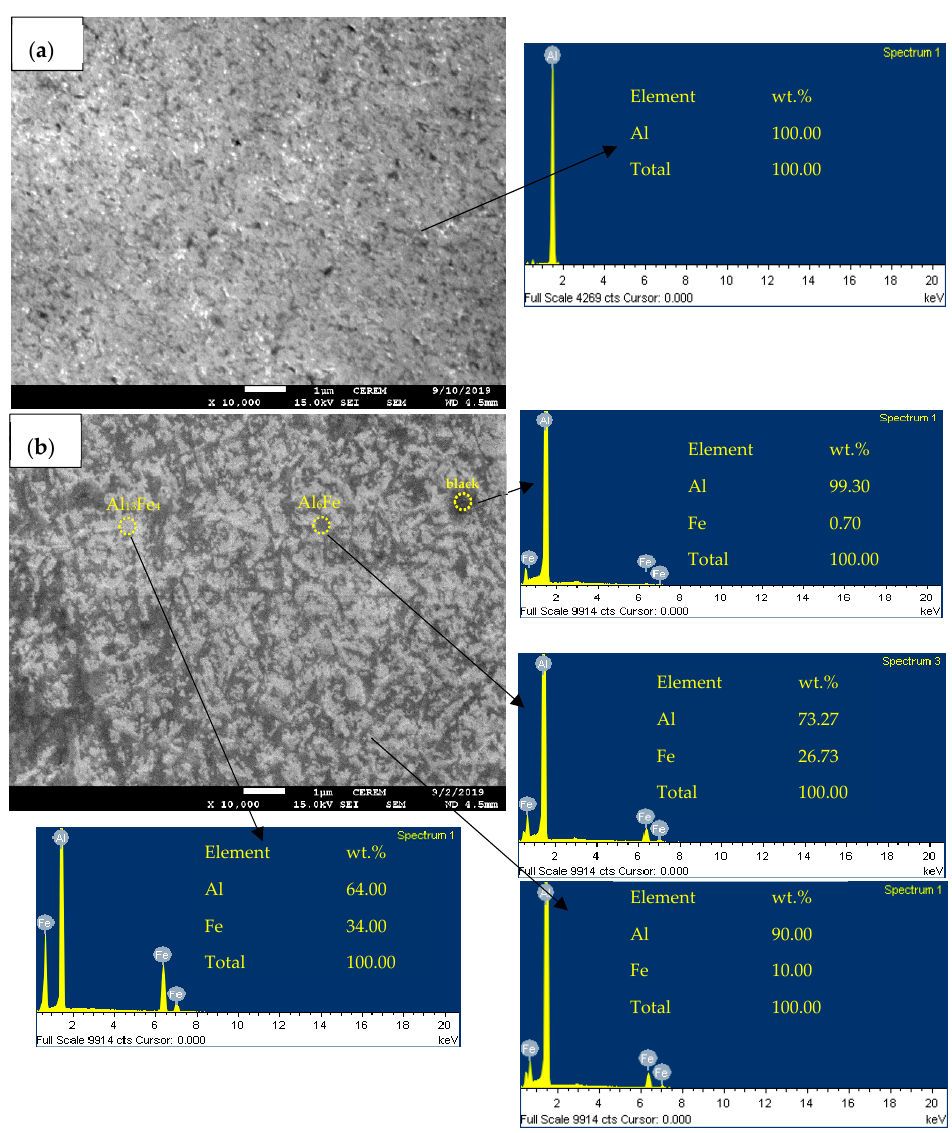
Figure 2. Scanning-electron-microscopy (SEM) micrograph and corresponding energy-dispersive- spectrometry (EDS) pattern of ( a ) pure Al and ( b ) Al-10 wt.% Fe alloys after sintering process. The X-ray diffraction patterns for the pure Al and Al-10 wt.% Fe alloys are shown in Figure 3. For the pure Al sample, the observed diffraction peaks corresponded to (111), (200), (220), and (222) planes of α -Al (JCPS = 85-1327). Peak broadening (after milling and sintering) along with a peak-intensity (height) decrease was observed in the Al-10 wt.% Fe alloys. This might be due to enhanced crystal-size refinement, it being amorphous, and the formation of new intermetallic compounds during MA process with addition of Fe [24]. In Al-10 wt.% Fe alloy-di ff raction